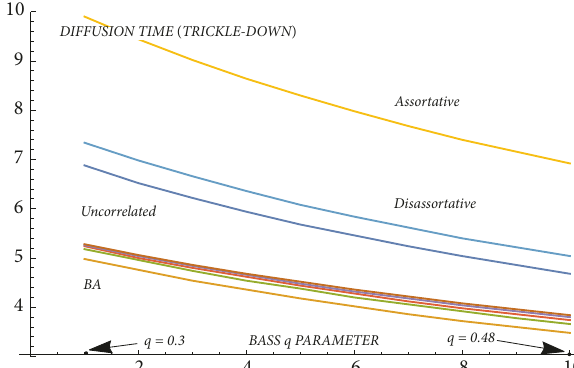
Figure 9: Time of the diffusion peak (in years) for the “trickle-down” modified Bass model on different kinds of scale-free networks with exponent 𝛾 = 3 , as a function of the imitation coefficient 𝑞 . All networks have maximum degree 𝑛 = 100 . The 𝑞 coefficient varies in the range 0.3 − 0.48 , corresponding to a typical set of realistic values in innovation diffusion theory [20]. The publicity coefficient 𝑝 𝑘 of the link class 𝑘 , with 𝑘 = 1,...,𝑛 , varies in inverse proportion to 𝑃(𝑘) (Section 6). The low-lying group of lines corresponds to BA networks with 𝛽 = 1,2,3,4,5 and the same assortativity coefficients as in Figure 2. The disassortative network is built with the Newman recipe (Section 3.4) with 𝑑 = 4 and has 𝑟 = −0.084 . The assortative network is built with our recipe (Section 3.3), with 𝛼 = 1/4 , and has 𝑟 = 0.827